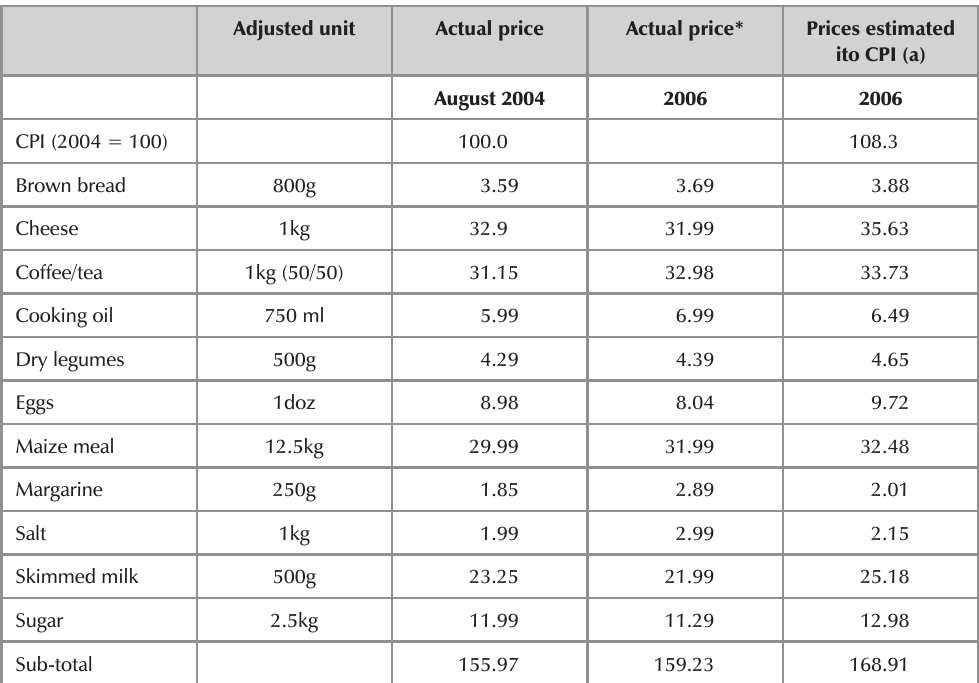
Comparison of actual and estimated prices of selected goods, 2004 to 2006 (all prices in